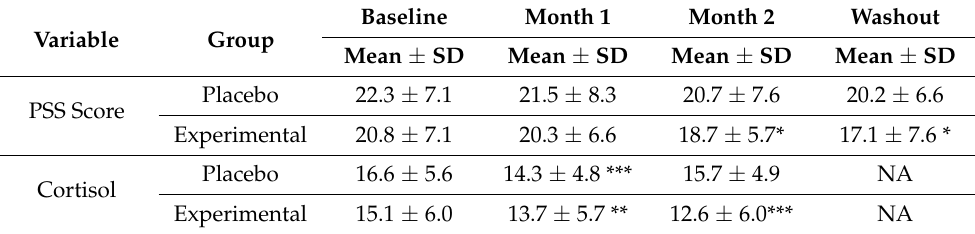
Month 1 vs. Month 2 vs. Washout vs. Baseline Baseline Baseline Mean ± SD Mean ± SD